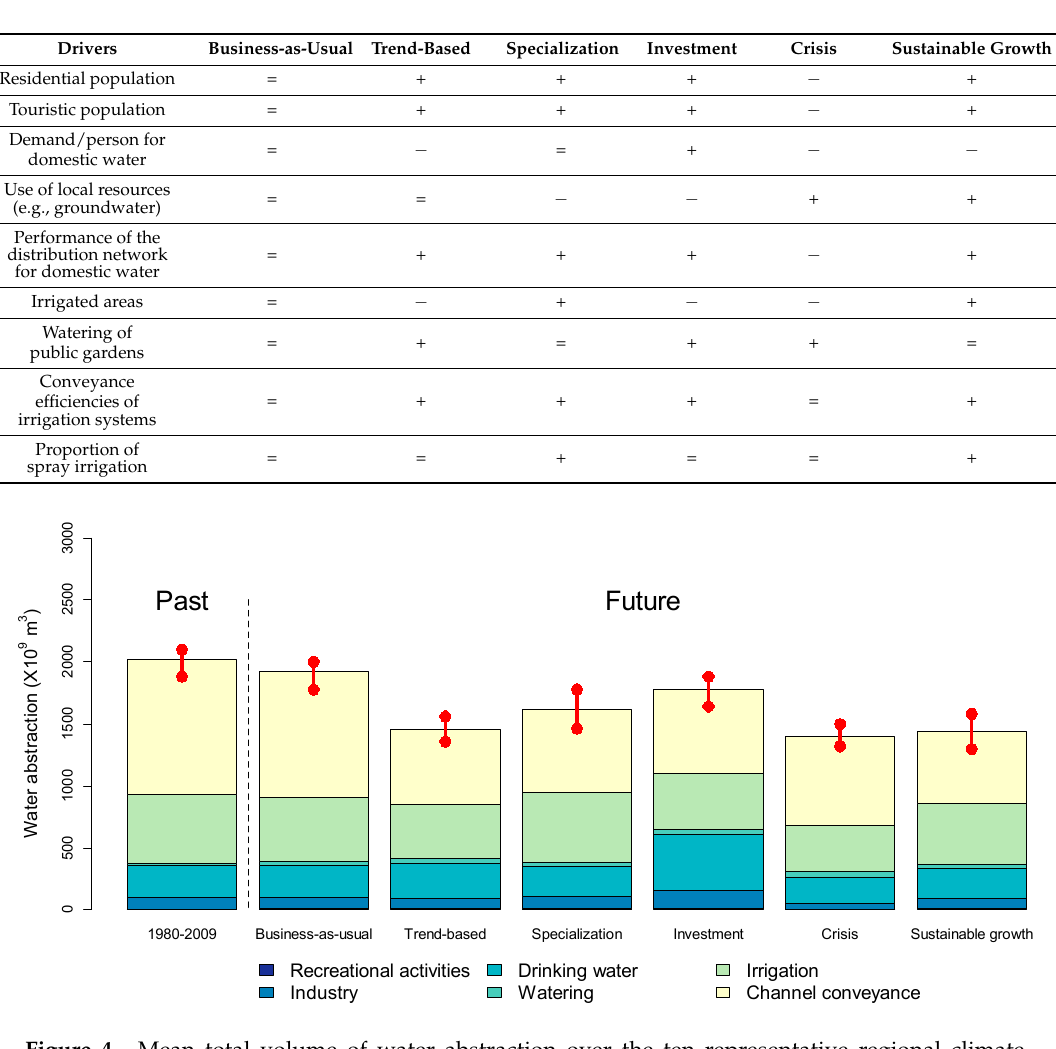
Figure 4. Mean total volume of water abstraction over the ten representative regional climate projections. Red dots indicate the minimum and the maximum values. The period “1980–2009” refers to results obtained with the baseline climate 1980–2009 simulated by the General Circulation Models (GCMs) and with the parameters of the water use models calibrated against observations over the period 1980–2009.